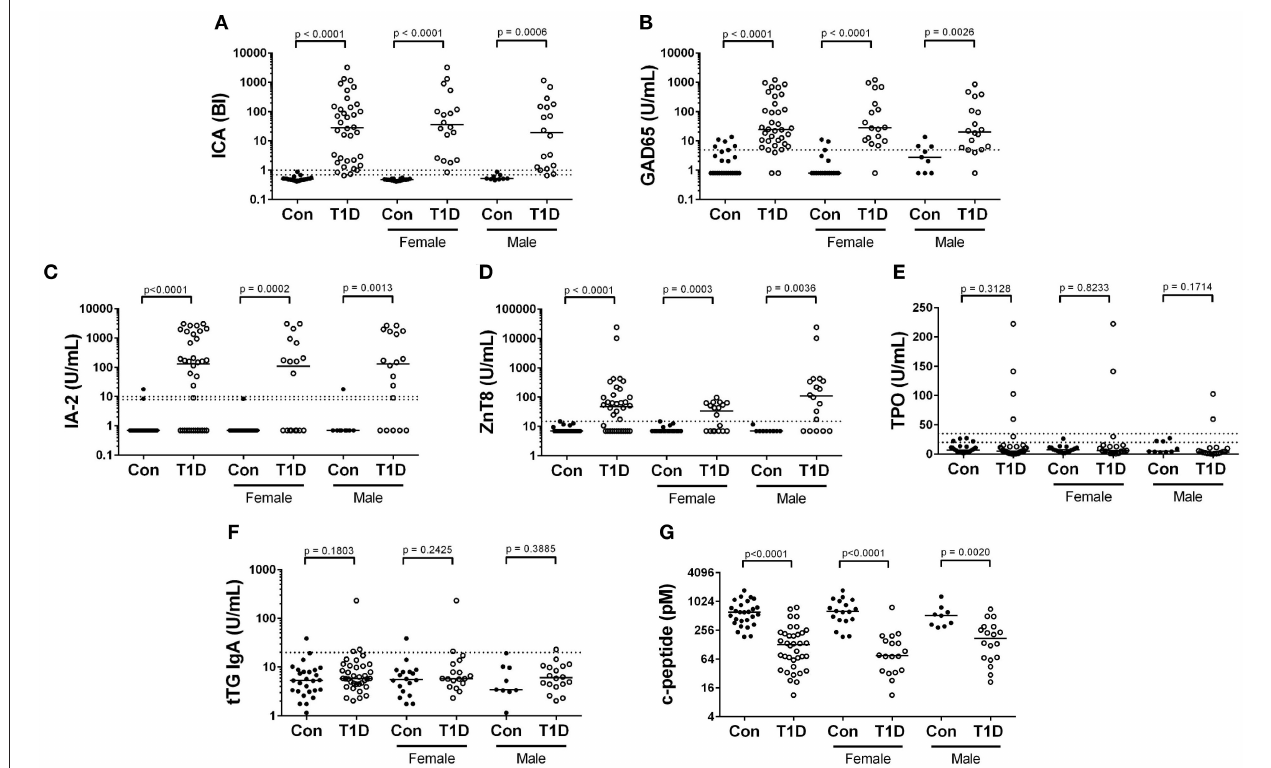
FIGURE 1 | Autoantibody and c-peptide levels among diagnosed T1D subjects and controls. (A–D) Abundance of islet cell antibodies (ICA), glutamate decarboxylase 2 (GAD65), insulinoma antigen 2 (IA-2), and zinc transporter 8 (ZnT8), were all significantly elevated among T1D subjects, consistent with the disease classification. (E,F) We observed no significant difference in abundance of antibodies targeting thyroperoxidase (TPO) and tissue transglutaminase (tTG), both of which have been previously associated with type 1 diabetes. (G) Random, non-fasting c-peptide levels were significantly decreased among T1D subjects compared to controls. Bars represent median values and BI signifies binding index. Dotted lines on autoantibody graphs represent cutoff points for designating positive or negative status.